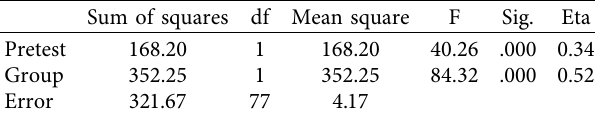
Table 5: Univariate analysis of covariance (ANCOVA) results.